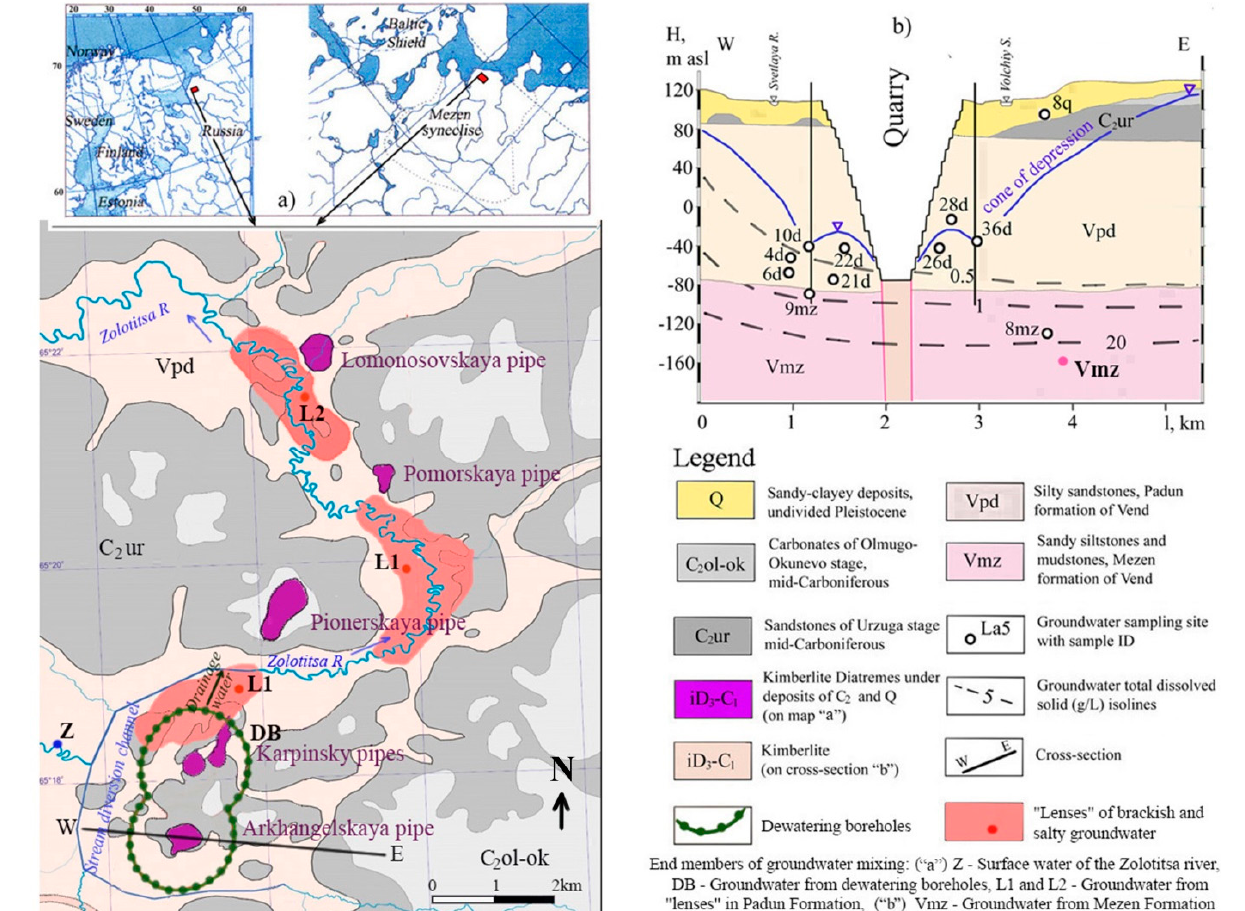
Figure 1. ( a ) General location of study site showing end members involved in mixing of surface waters of Zolotitsa River (Z) with fresh groundwater pumped from dewatering boreholes (DBs); brackish and salty groundwater pumped from “lenses” in Vendian Padun Formation (L1 and L2); and ( b ) salty groundwater pumped from Vendian Mezen Formation (Vmz).